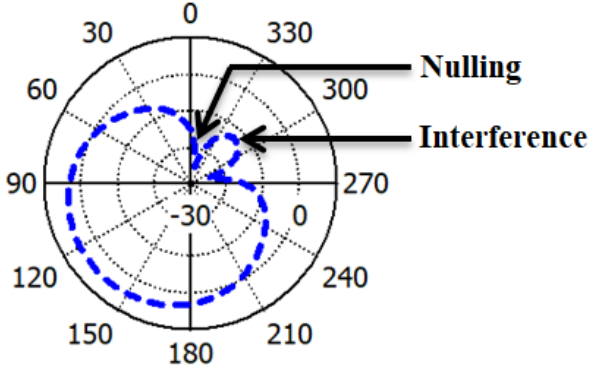
Figure 13. Polar radiation pattern of the single antenna by indicating nulling and interference.